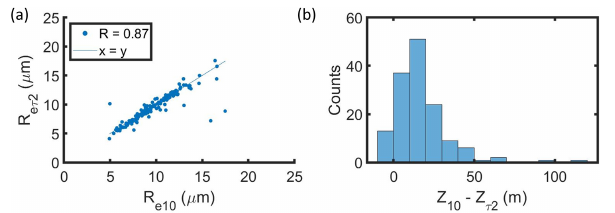
Figure 7. (a) Scatter between R e at two optical depths below the cloud top ( R e τ 2 ) versus R e averaged over the top 10% of the cloud layer ( R e10 ) and (b) histogram of the difference between Z 10 and Z τ 2 for profiles with a MODIS retrieval co-located with in situ data for (cid:49)T less than 3600s.